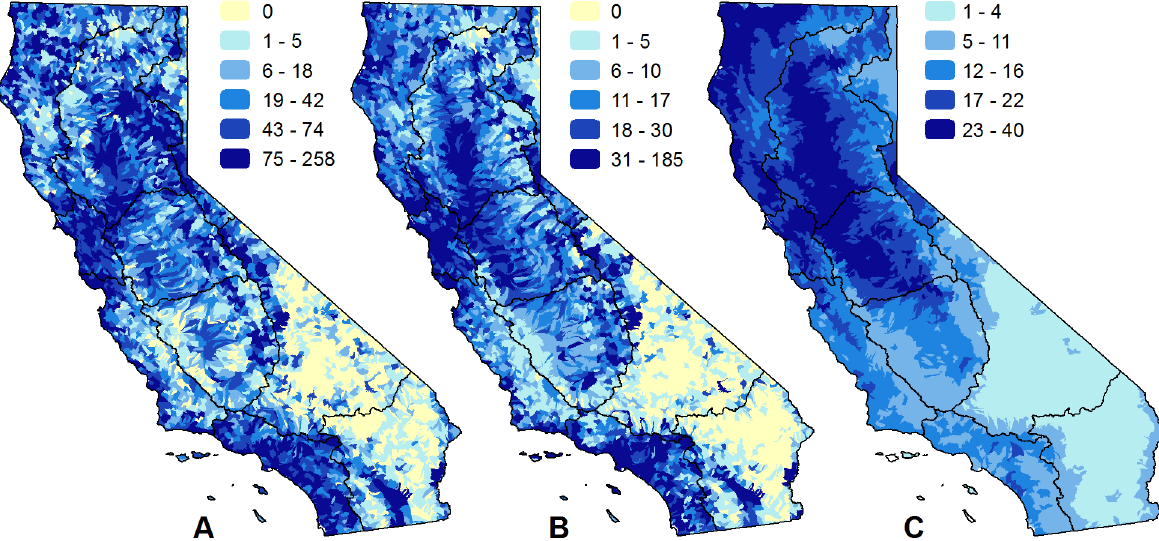
Fig 7. Patterns of richness by data type of California freshwater species. Maps show the number of native freshwater species when summarized by: (A) observational data recorded after 1980; (B) observational data recorded before 1980 or observations of extirpated populations; and (C) data that includes range maps, historical range maps, modeled habitat, professional judgment, critical habitat designations, and management area designations. Spatial data with an unknown observation date or unknown type are not included in any panel. The black lines on the maps represent the major hydrologic regions in the study